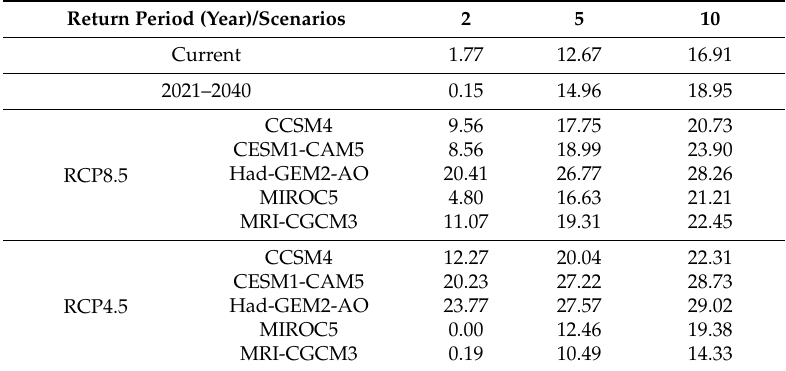
Figure 11. Probabilities of exceedance of the annual maximum water shortage amounts under RCP 8.5 ( a ) and 4.5 ( b ). ( a ) and 4.5 ( b ). Table 5. Analysis of maximum amount of water under different return periods and scenarios.